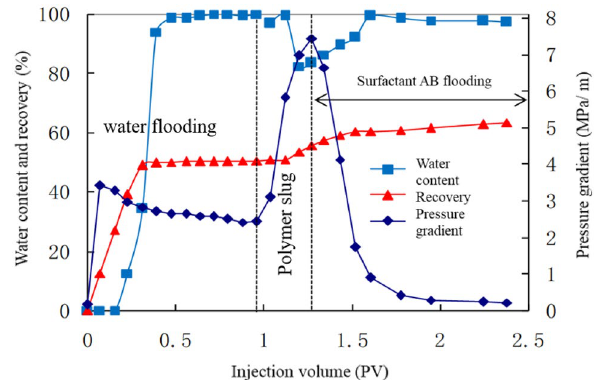
Fig. 16 Core flooding experiment results of high concentration poly- mer slug + surfactant AB mixture (separated) injection